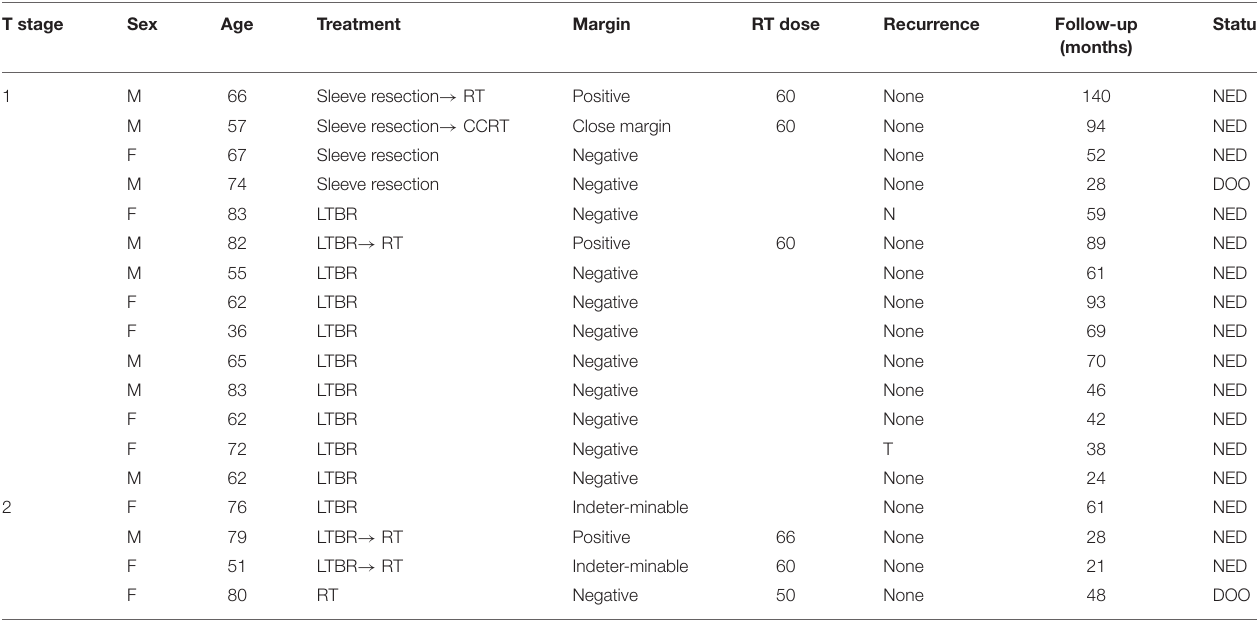
TABLE 1 | Treatment details in T1 and T2